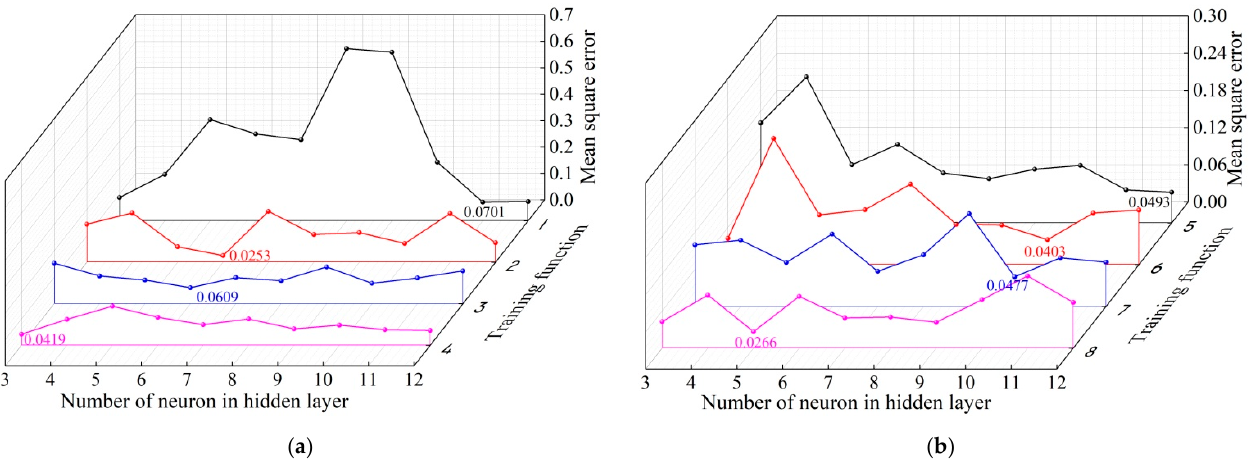
Figure 7. Change of mean square error of different training functions with the number of neurons in the hidden layer: ( a ) training functions No. 1 to No. 4; ( b ) training functions No. 5 to No. 8.